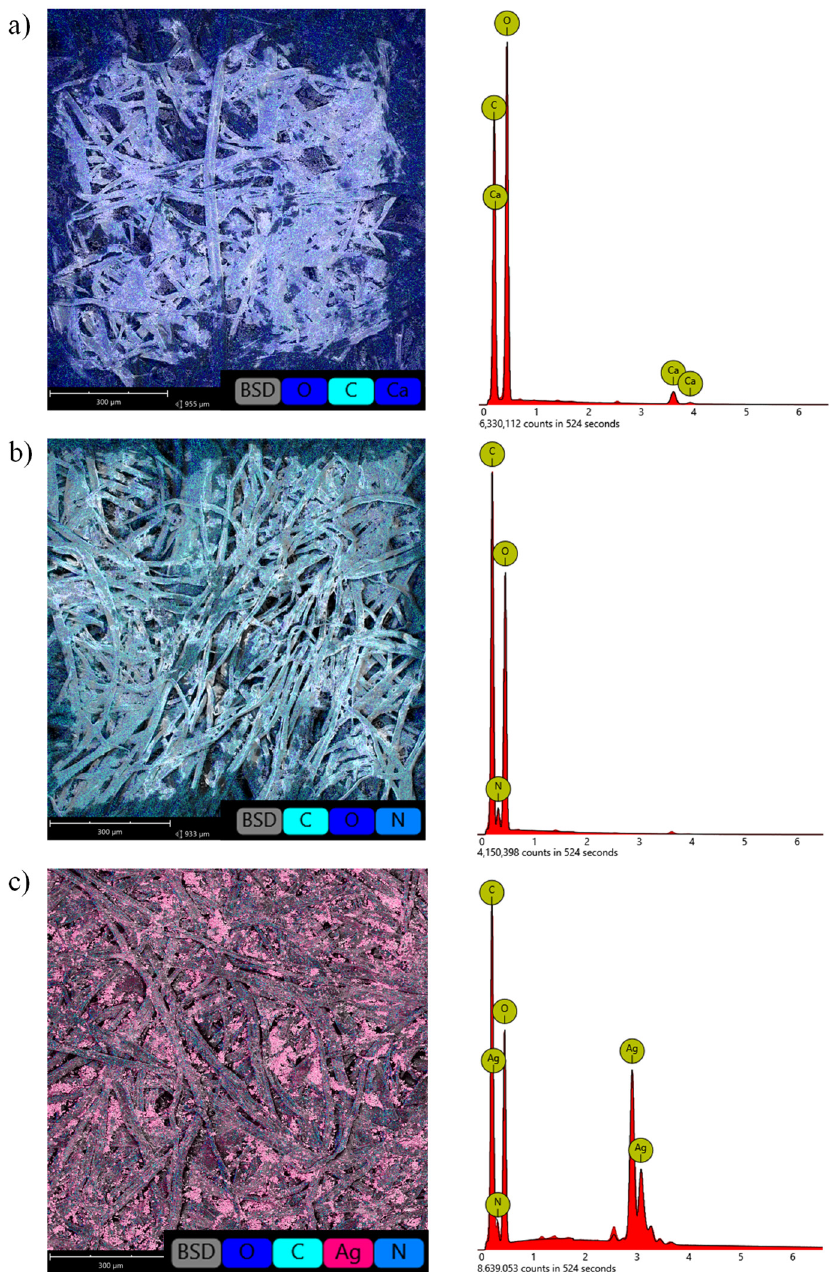
Figure 3. Results of EDS analysis of the surface layer of ( a ) P, ( b ) PD and ( c ) PAg samples.